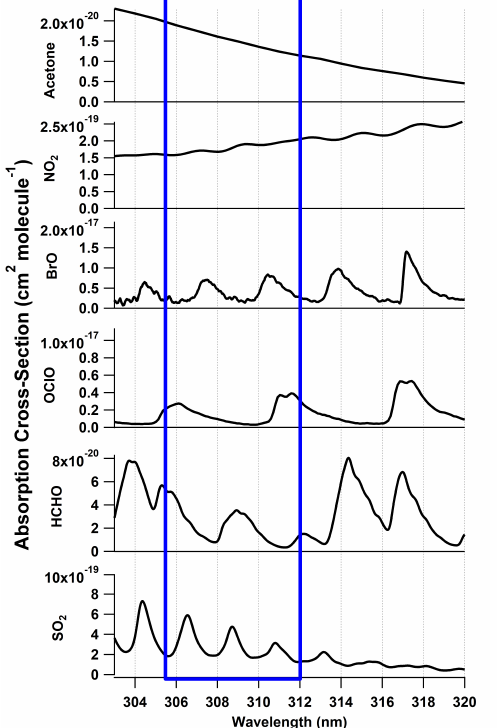
Figure 1. Absorption cross sections of species absorbing in the 300–320 nm range including, SO 2 [45], NO 2 [42], BrO [43], OClO [41], acetone [44], and HCHO [46]. The spectral fitting window for the SO 2 BBCEAS is shown in